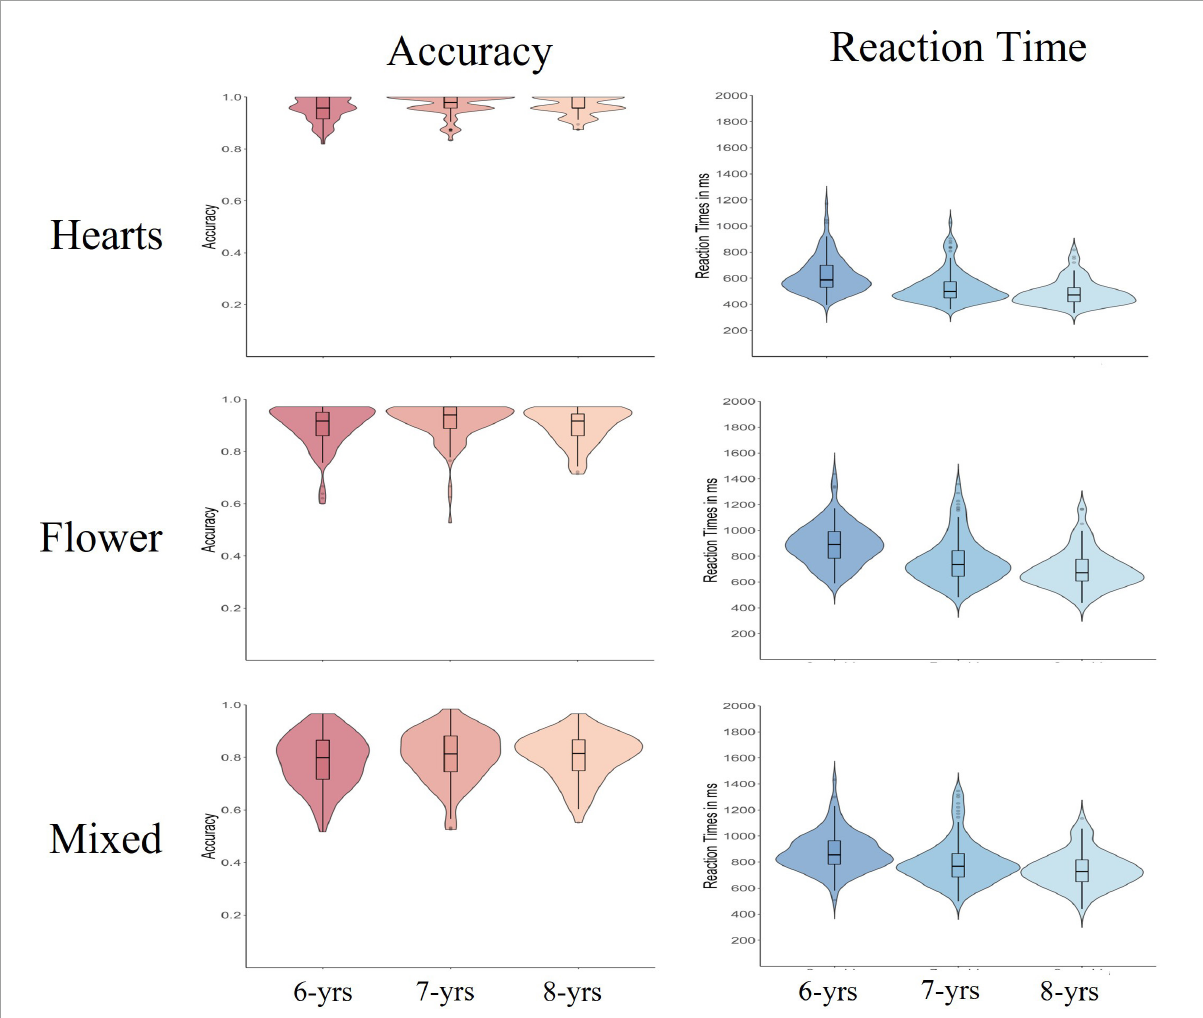
FIGURE1 Violin diagrams (combining box and scatter plots) for Accuracy and Reaction Times for the three blocks of the Hearts and Flower Tasks, as a function of age group. The figure depicts the median (horizontal line in the box plot), the lower and upper quartile (borders of the box), 1.5 time the interquartile difference (the whiskers), and the distribution (the external